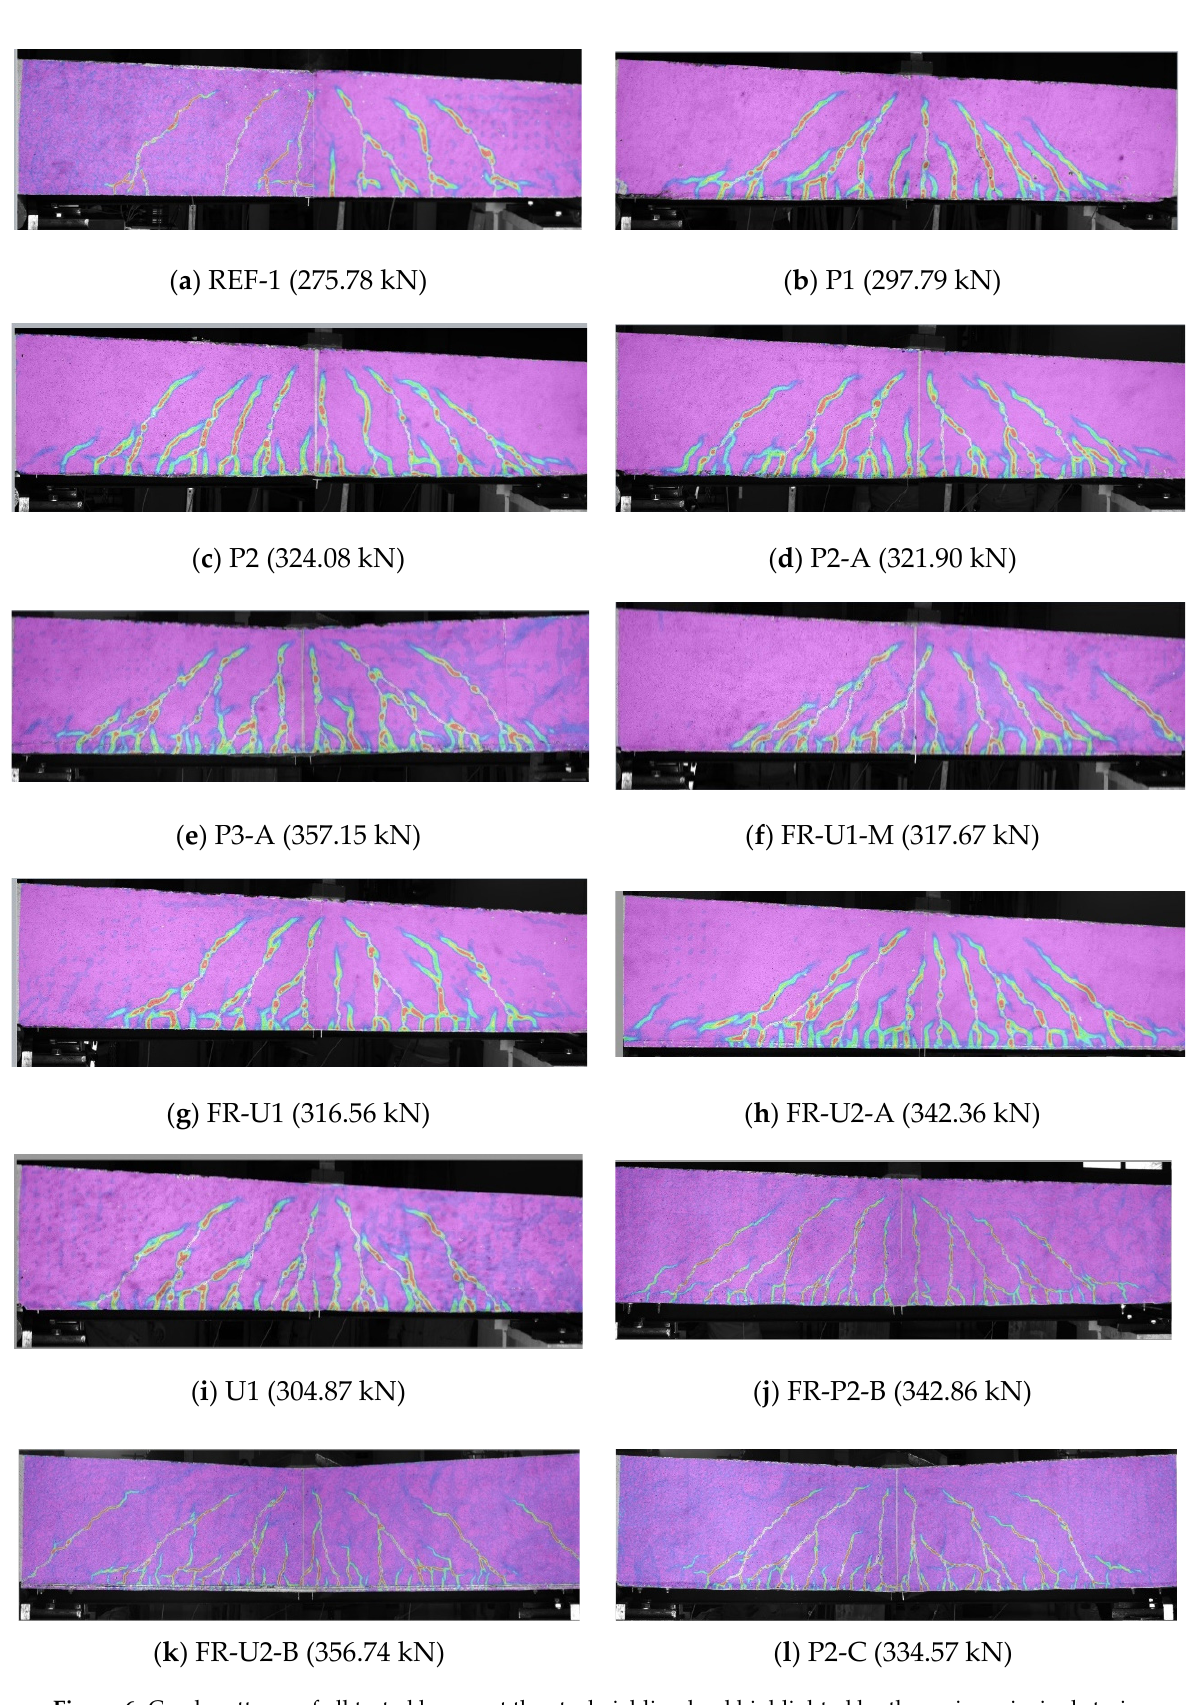
Figure 6. Crack patterns of all tested beams at the steel yielding load highlighted by the major principal strain.